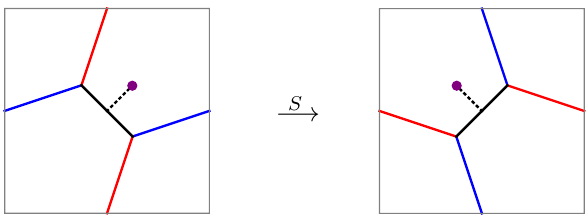
Figure 7 . The modular S transform of the torus one-point function of a defect operator (purple dot) attached to a TDL graph (consisting of red, blue, and dotted lines, representing TDLs of di(cid:11)erent